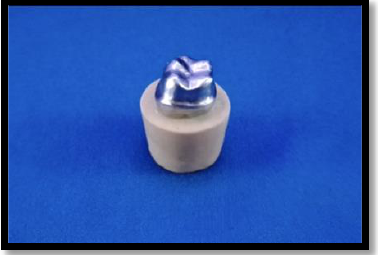
Figure 1: The final metal die with stone